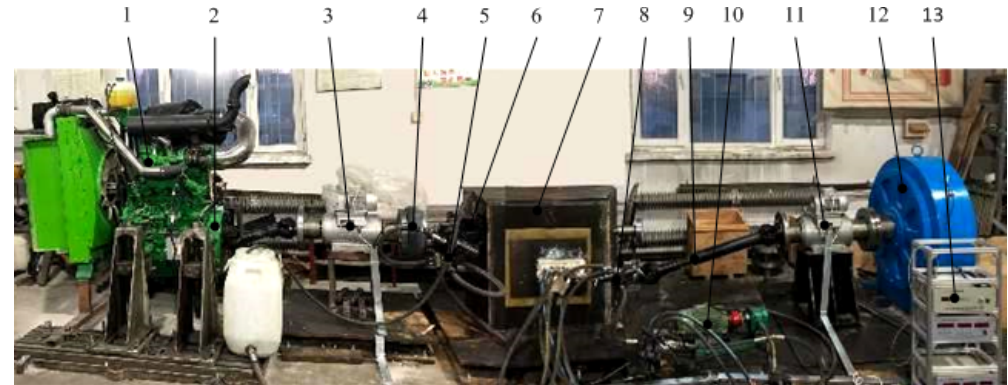
Figure 2. HMCVT test bench. 1: Engine, 2: Speed torque sensor, 3: Flexible coupling, 4: Quantitative motor, 5: Variable displacement pump, 6: HMCVT, 7: Solenoid directional control valve assembly, 8: Universal joint coupling, 9: Auxiliary pump, 10: Speed torque sensor, 11: Magnetic powder brake, 12: Data acquisition